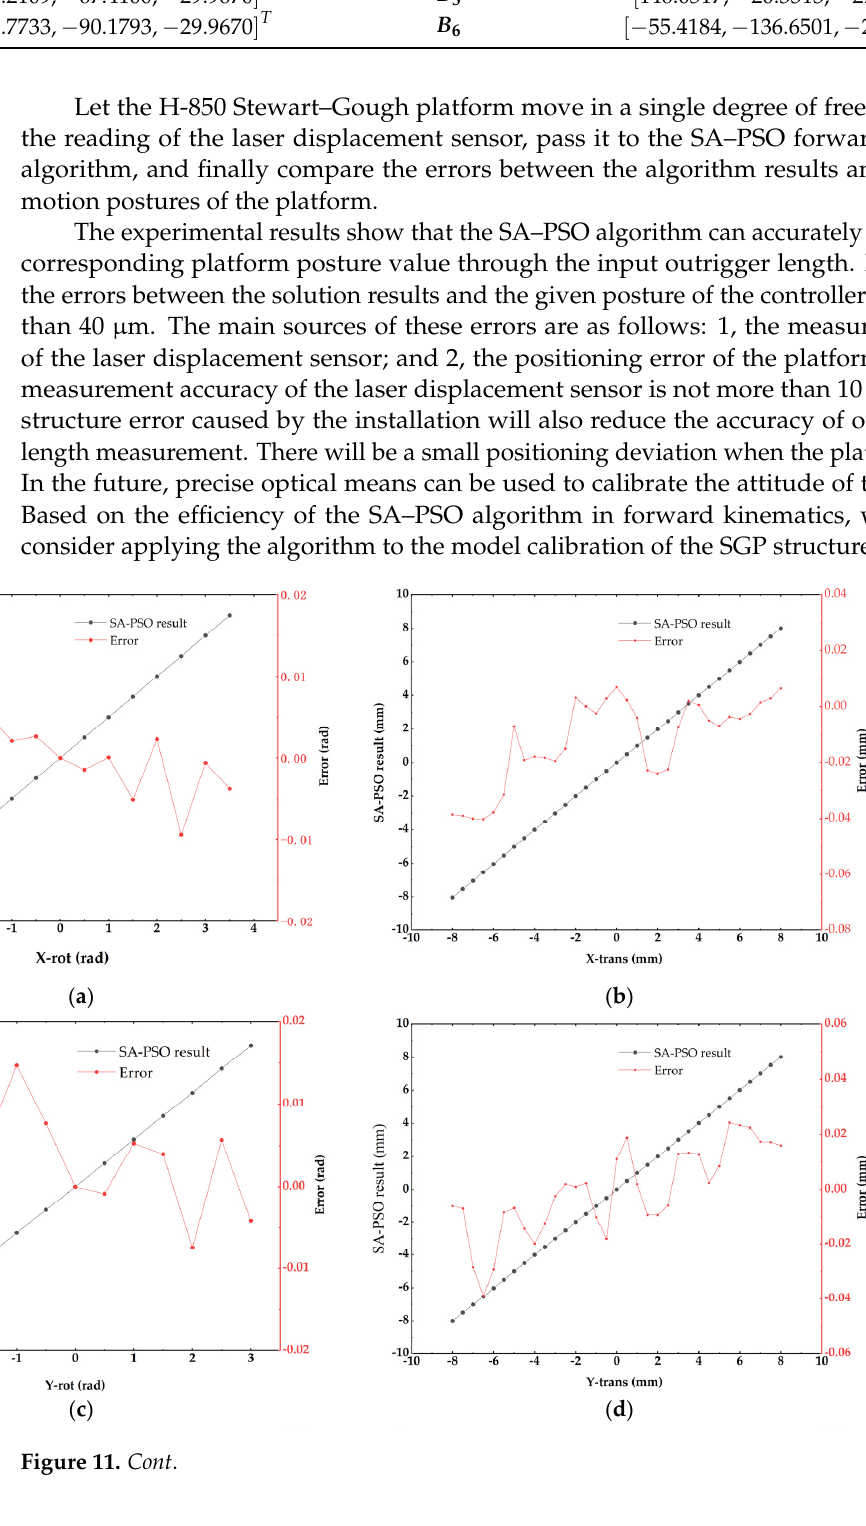
( f ) Figure 11. the SA–PSO results and the error for the experiments. ( a ) X rotation results and errors. ( b ) X translation results and errors. ( c ) Y rotation results and errors. ( d ) Y translation results and errors. ( e ) Z rotation results and errors. ( f ) Z translation results and errors. 5. Conclusions Forward kinematic solution is meaningful and vital for the building and analysis of the Stewart–Gough platform. In this paper, the link between the length of six outriggers and posture in six dimensions is built by the proposed optimum algorithm. Through the calculation of the inverse kinematic solution and optimum of the input posture, the result gradually converges to the target solution. To overcome the disadvantage of the standard